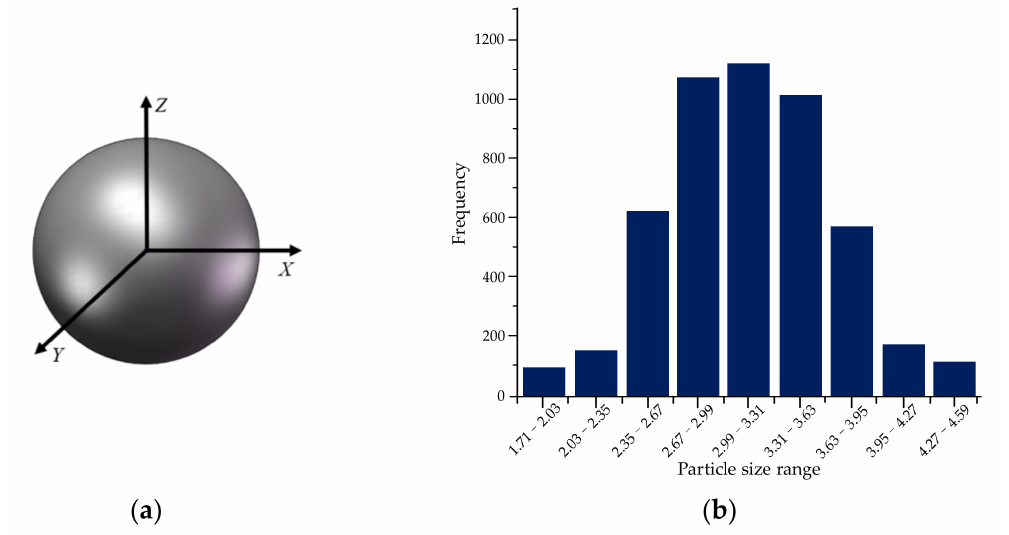
Figure 1. Geometric model and particle size distribution of granular fungal fertilizer: ( a ) geometric model; ( b ) particle size